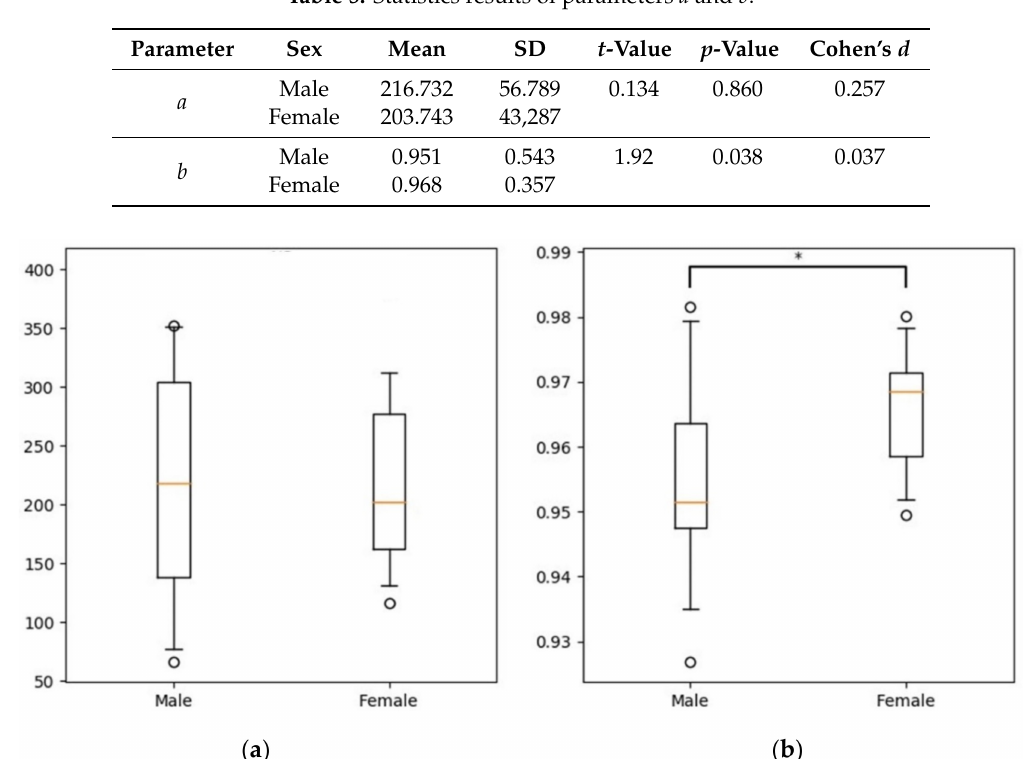
Figure 5. The comparison of exponential function parameters ( a ) and ( b ) for males and females (* p <